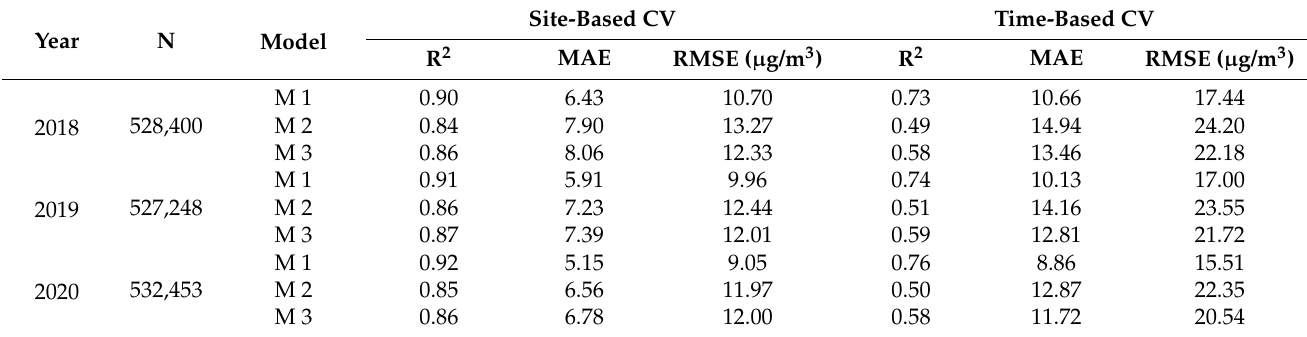
Table 1. Cross validation results for annual (M1 and M2) and daily (M3) models by Years.